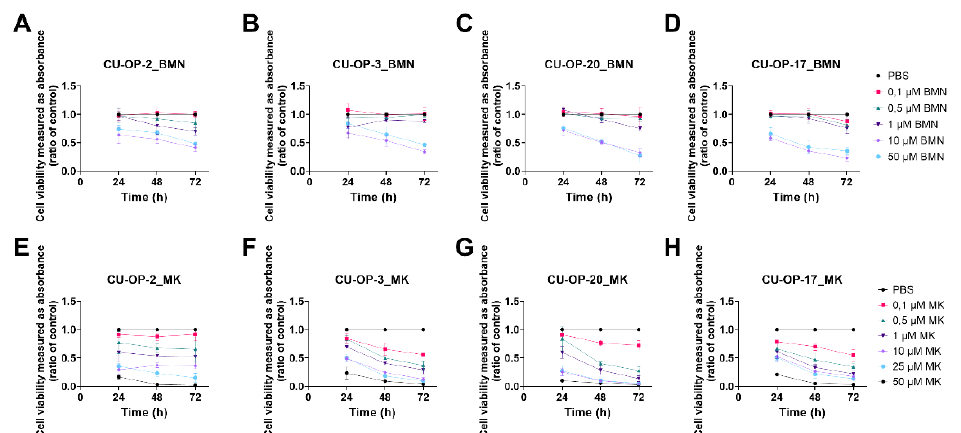
Figure 2. WST-1 viability assay on HPV + cell lines CU-OP-2, CU-OP-3, and CU-OP-20, and HPV − cell line CU-OP-17. Cell viability analysis measured as absorbance after 24, 48, and 72 h of single treatments with BMN-673 ( A – D ), or MK-1775 ( E – H ). BMN denotes BMN-673 and MK denotes MK-1775.